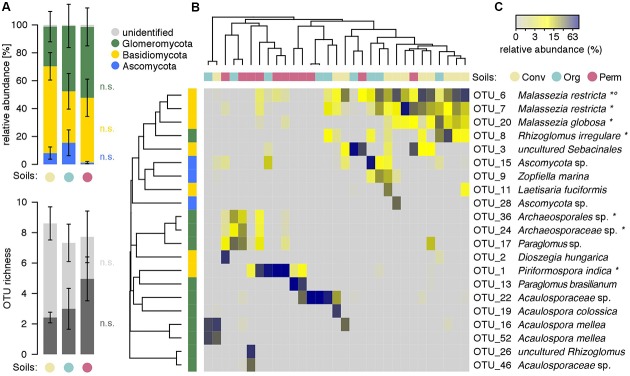
Root fungi profiles from trap cultures. (A) Mean abundances of fungal phyla plotted by soil groups. Data were normalized by sampling depth and expressed as percentage relative abundance. (B) Mean fungal (light gray) and Glomeromycota (dark gray) OTU richness, reported by soil groups. The dataset was independently subsampled 100 times, OTU richness determined and averaged for each sample. (C) The heatmap displays all abundant (defined as >1% mean relative abundance) OTUs in percentage relative abundance in all samples. Dendrograms summarize similarities between samples (in columns) and between OTUs (in rows) based on Bray–Curtis. Non-parametric Kruskal–Wallis test was used to examine differences between soil groups (n.s., not significant, ∗P < 0.05, °P < 0.05 false discovery rate corrected).